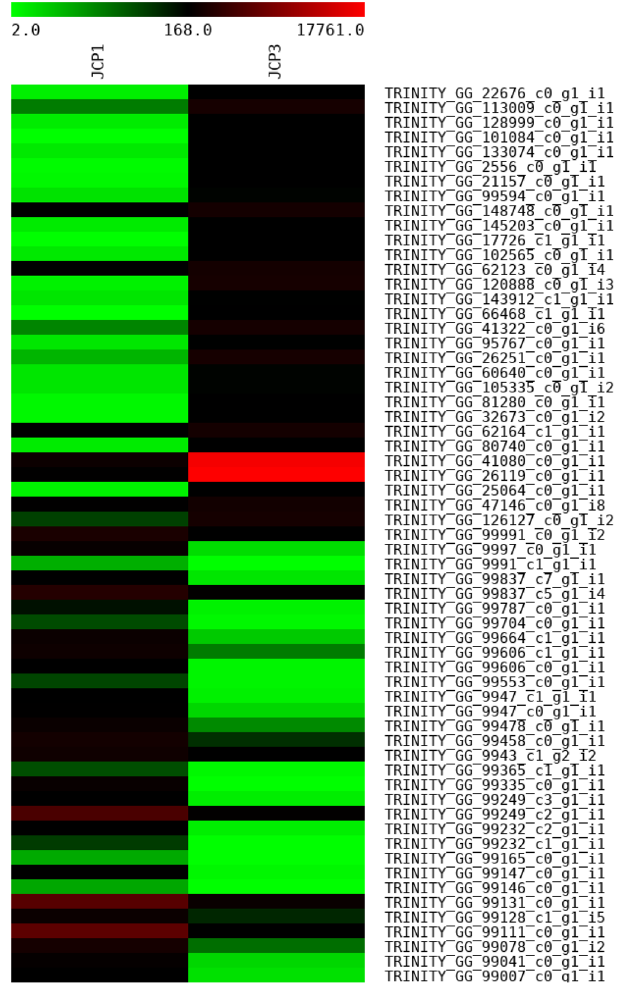
Figure 2. Heatmap analysis of the up and down regulated DEGs between the control and the heat-stress treated wheat genotype Raj 3765. The upper 30 genes are the up-regulated DEGs while the lower 30 genes are the down- regulated